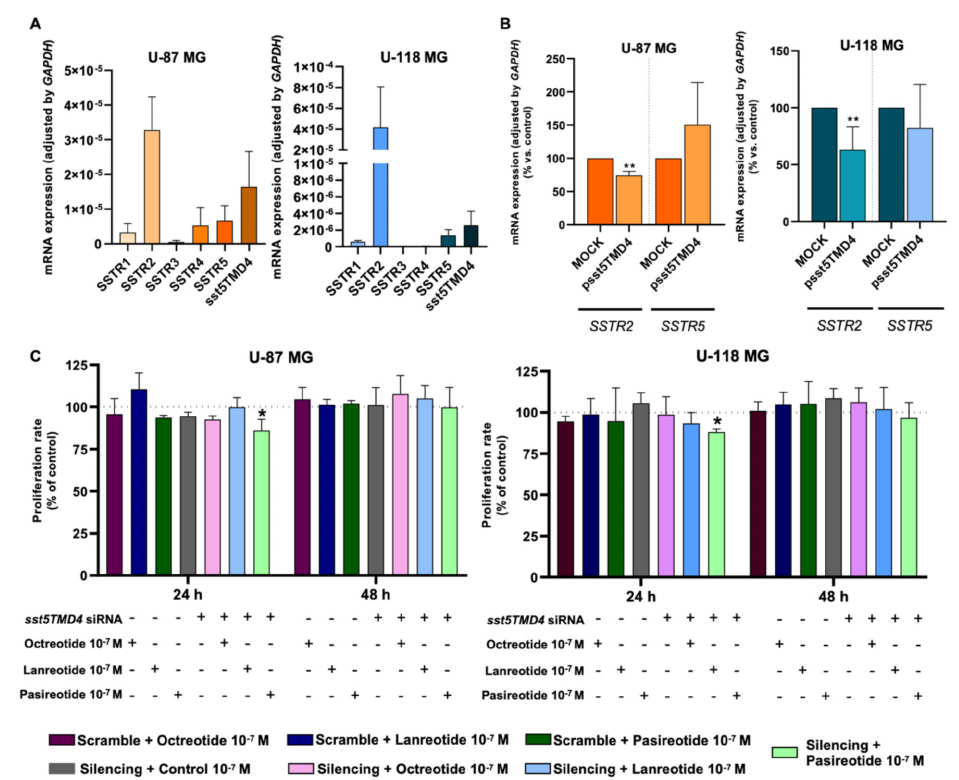
Figure 5. Overexpression of sst5TMD4 alters the basal expression of SSTR2 in GBM cells and sensitized the response of GBM cells to pasireotide treatment. ( A ) Basal expression profile (mRNA levels) of somatostatin receptor subtypes ( SSTR1-5 ) in U-87 MG and U-118 MG cell lines ( n = 3). ( B ) mRNA levels of SSTR2 and SSTR5 after sst5TMD4 overexpression (vs. control; pointed line) in U-87 MG and U-118 MG cell lines ( n = 4). ( C ) Comparison of the proliferation rate of U-87 MG and U-118 MG in response to the treatment with different somatostatin analogs (octreotide, lanreotide or pasireotide) under basal-normal conditions (scramble control cells; pointed line) vs. sst5TMD4 - silenced cells ( n = 3). Data represent means ± SEM. (*) p < 0.05, (**) p < 0.01 significantly differ from control